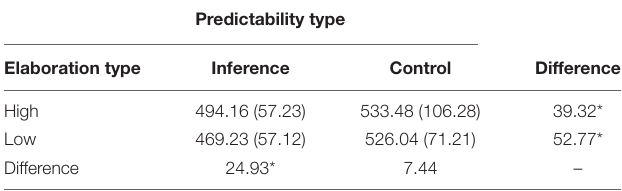
TABLE 3 | Average latency on probe word pronunciation (and SDs) in milliseconds